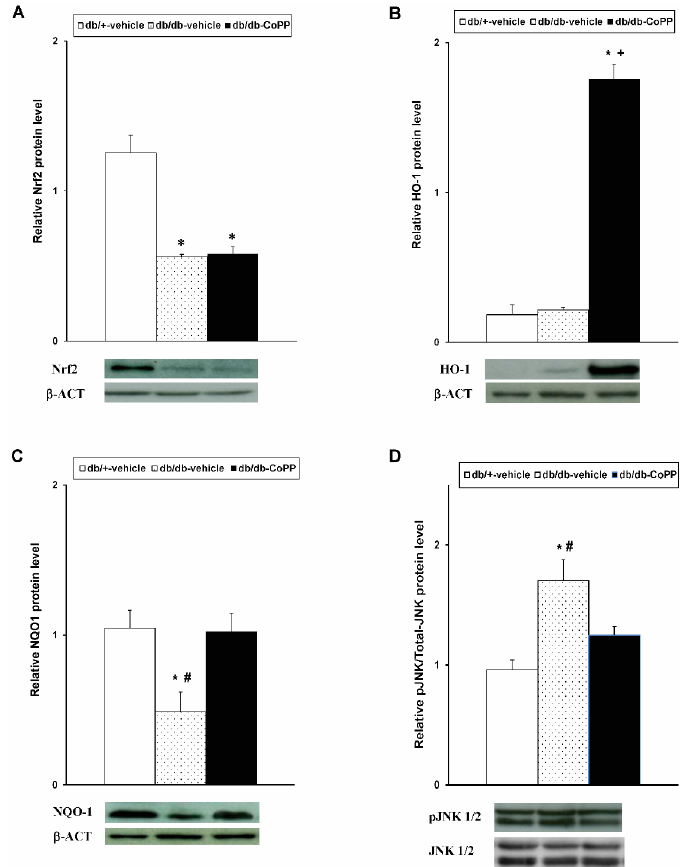
Figure 3. Effects of CoPP treatment on the protein levels of Nrf2, HO-1, NQO1 and JNK in the sciatic nerve of diabetic mice. The protein levels of Nrf2 ( A ), HO-1 ( B ), NQO1 ( C ) and JNK ( D ) in the sciatic nerve from db/db mice treated with CoPP or vehicle and in db/+ mice treated with vehicle are represented. For each protein, * indicates significant differences as compared to db/+ mice treated with vehicle and # indicates significant differences vs. db/db mice treated with CoPP ( p < 0.05, one-way ANOVA, Student Newman Keuls test). Examples of western blots for Nrf2, HO-1, NQO1 and pJNK proteins in which β -actin or total JNK were used as loading controls are also shown. Each column represents the mean and vertical bars indicate SEM; n = 4 samples per